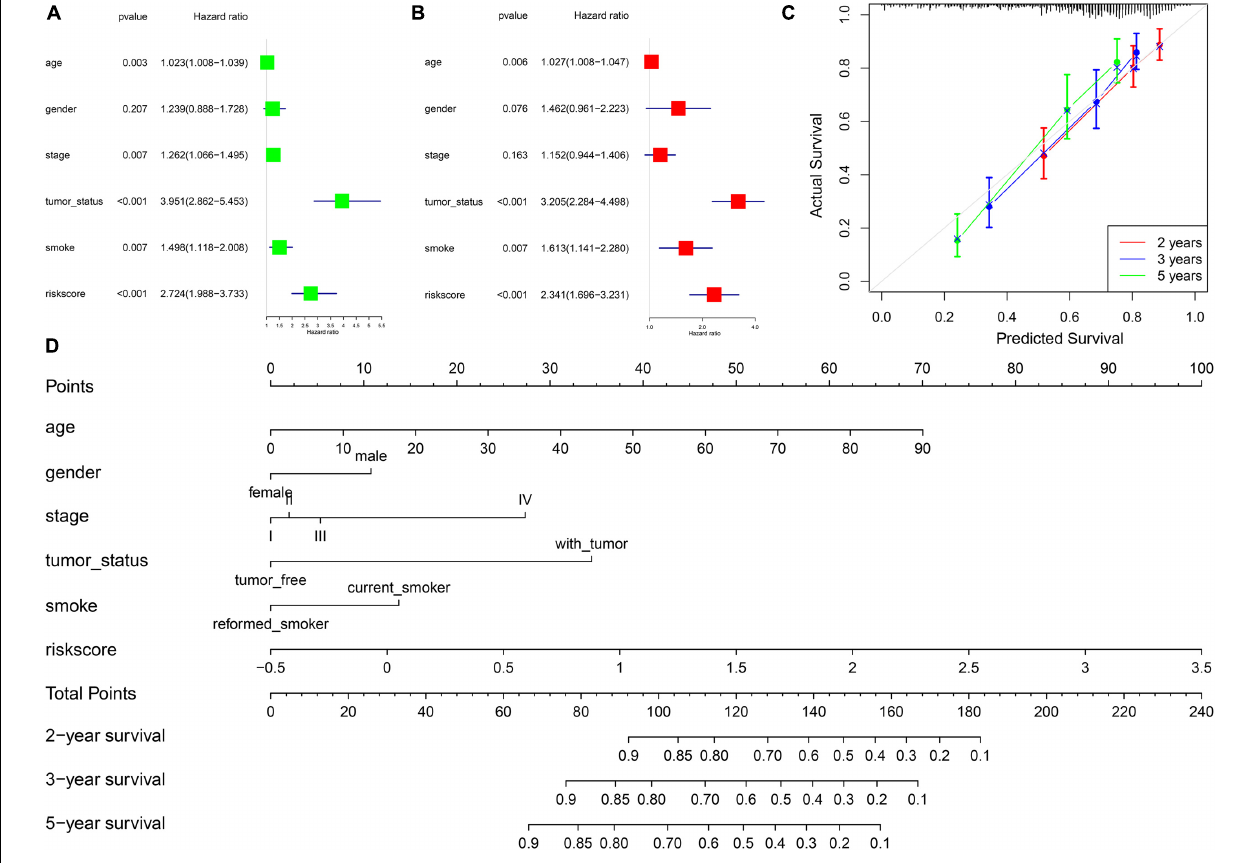
FIGURE 4 | The association between risk scores and prognosis of LUSC. (A) Univariate Cox regression analysis. (B) Multivariate Cox regression analysis. (C) Calibration curve of nomogram. (D) Construction of